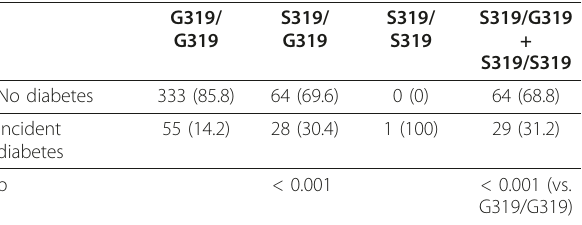
Table 2 HNF1A genotype frequencies according to 10-year cumulative incident type 2